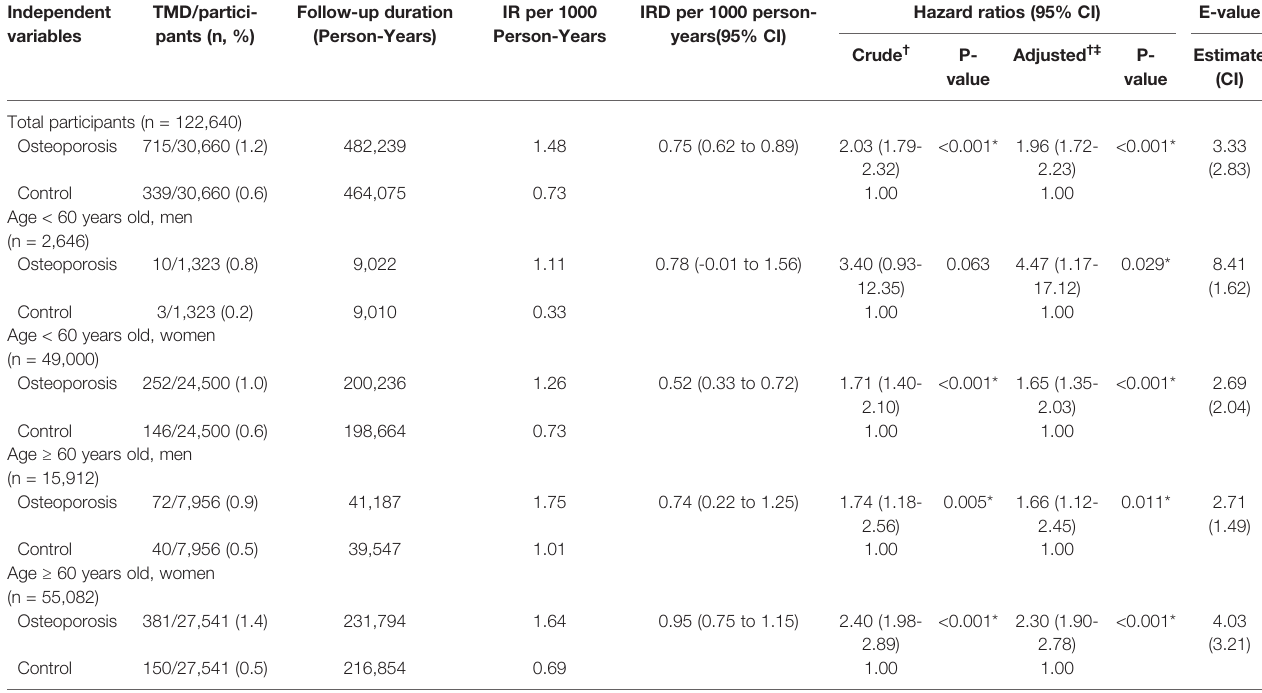
TABLE 2 | Crude and adjusted hazard ratios (95% con fi dence interval) for temporomandibular joint disorder in osteoporosis and control groups according to age and sex. Independent